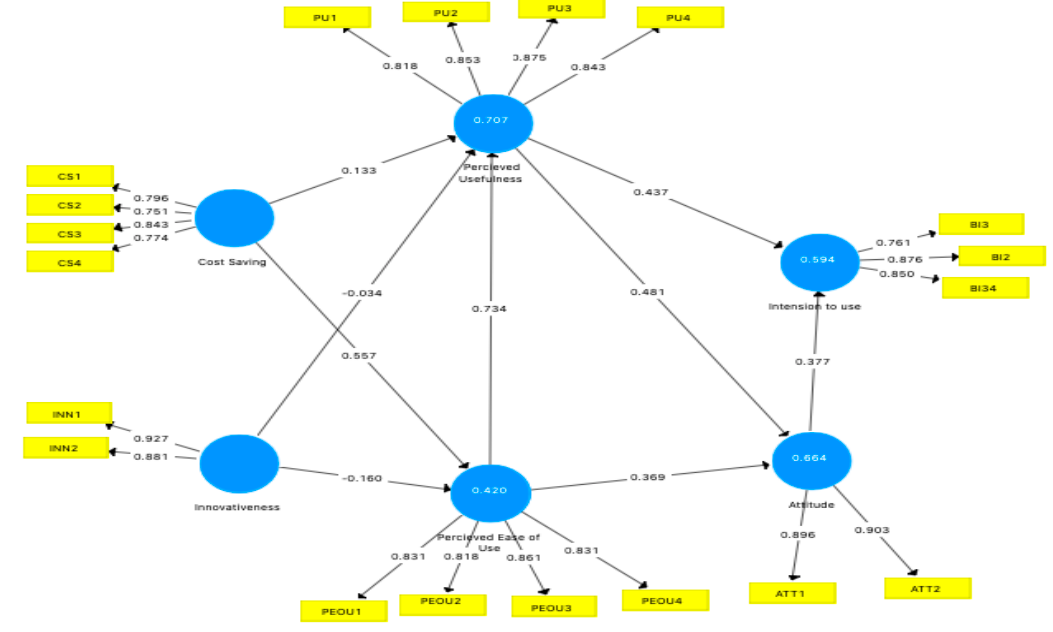
Figure 3. Measurement model.